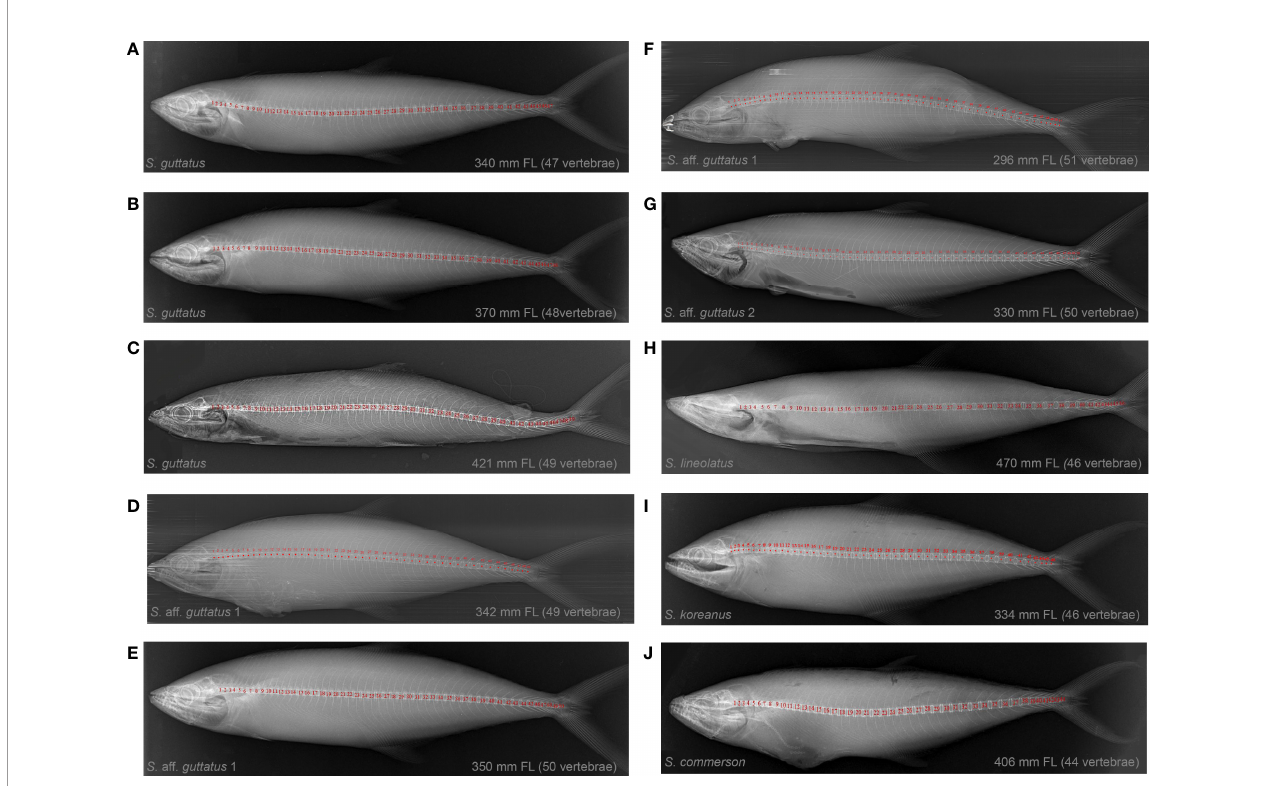
FIGURE 5 | Digital X-ray images of Scomberomorus species (A – J) from the Northern Indian Ocean revealing the diversity, fork length (FL), and number of